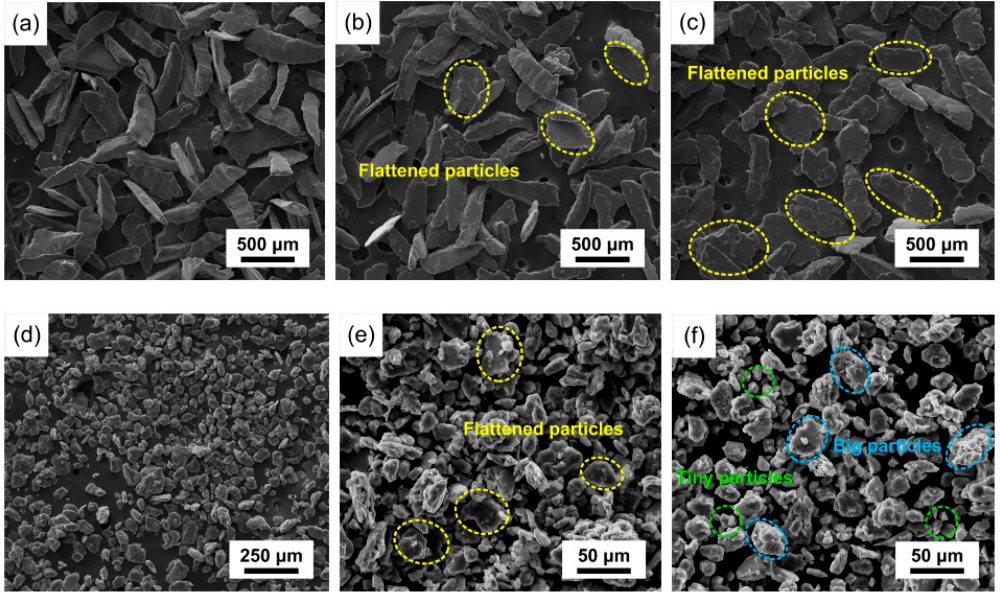
Figure 2. Morphology evolution of AZ91: ( a ) 15 min; ( b ) 30 min; ( c ) 60 min; ( d ) 120 min; ( e ) 180 min; ( f ) 240 min.